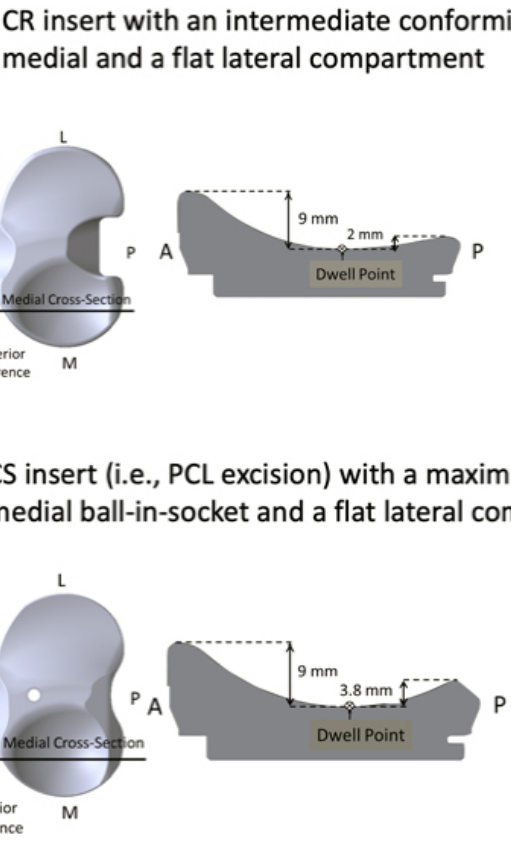
Figure 3. Images show ( A ) the medial sagittal dimensions of a CR (PCL retaining) insert used in the present study) with intermediate conforming tibial articulation and ( B ) for comparison, a CS (PCL substituting) insert with a ball-in-socket tibial